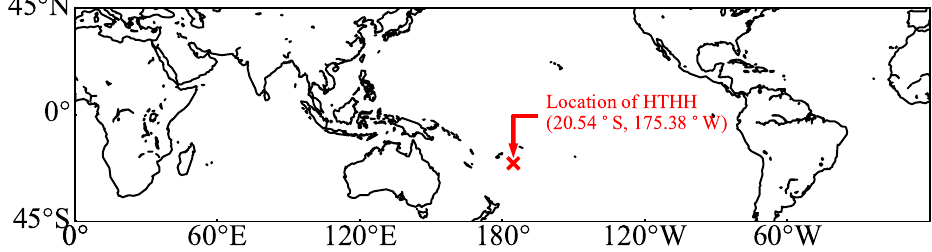
Figure 1. The location of the Hunga Tonga-Hunga Ha’api volcano (HTHH, 20.54 ◦ S, 175.38 ◦